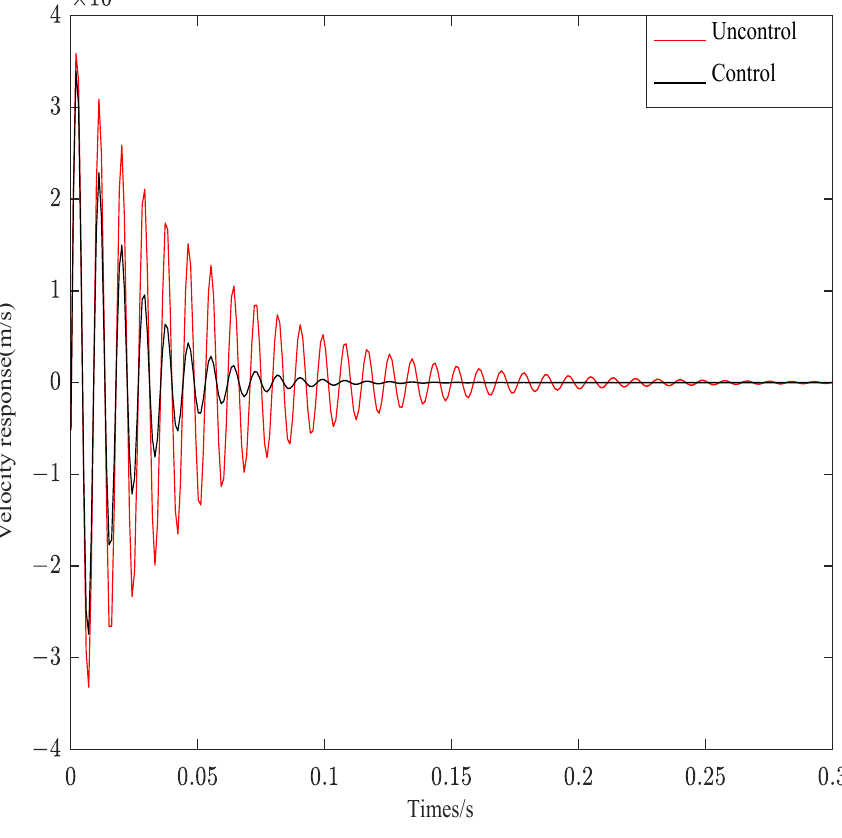
Figure 14. Velocity response under impulse signal. Figure 15 is the response curve of structure 3 under complex aperiodic signal. Figure 16 is the response curve of structure 3 under white Gaussian